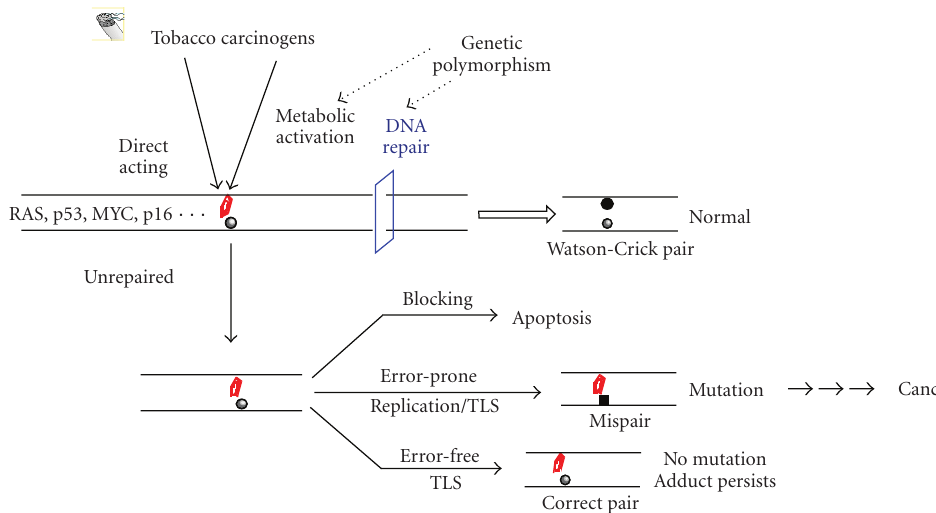
Figure 1: Schematic presentation of the formation, repair and mutagenic potential of tobacco carcinogen-induced bulky adducts in genomic DNA. The formation of a bulky DNA adduct (marked in red), if not repaired or poorly repaired, results in multiple genetic changes such as cell death and gene mutation. TLS (translesion DNA synthesis) can prevent a mutation by error-free incorporation opposite the adduct. Error-prone incorporation at the adduct site by replicative or translesional DNA pols is the source for mutation. Only those adducts that finally escape all the defense mechanisms may lead to biologically important